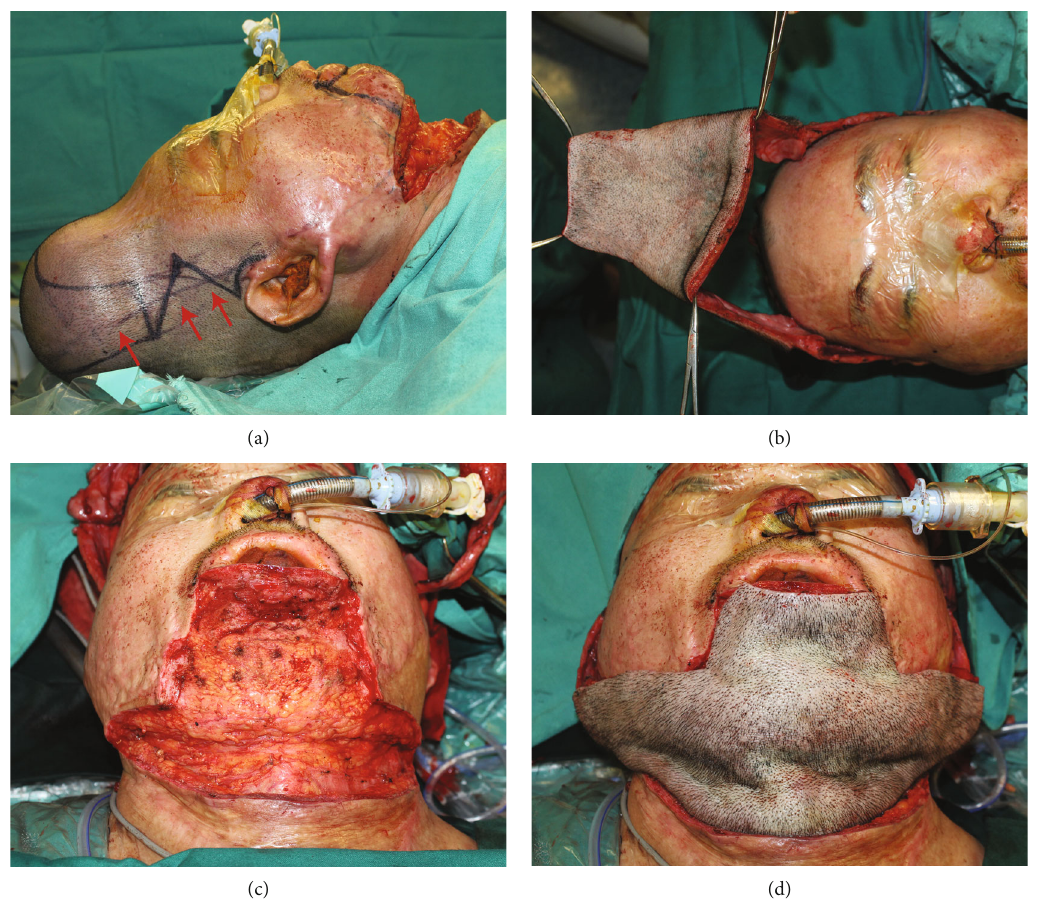
Figure 1: Surgical procedures of the preexpanded bipedicled visor fl ap. (a) Tissue expansion and fl ap design: a total volume of 800ml was achieved for tissue expansion and the fl ap was designed based on the bilateral super fi cial temporal vessels. The red arrow indicated the running course of the super fi cial temporal vessel. (b) Flap harvest: the visor fl ap was elevated according to the fl ap design with the super fi cial temporal vessels intact as pedicles at the two sides. (c) Scar excision: the scar and periwound contraction of the lower lip and the anterior cervical region were thoroughly released. (d) Flap transfer: the elevated fl ap was rotated 180 degrees to cover the recipient